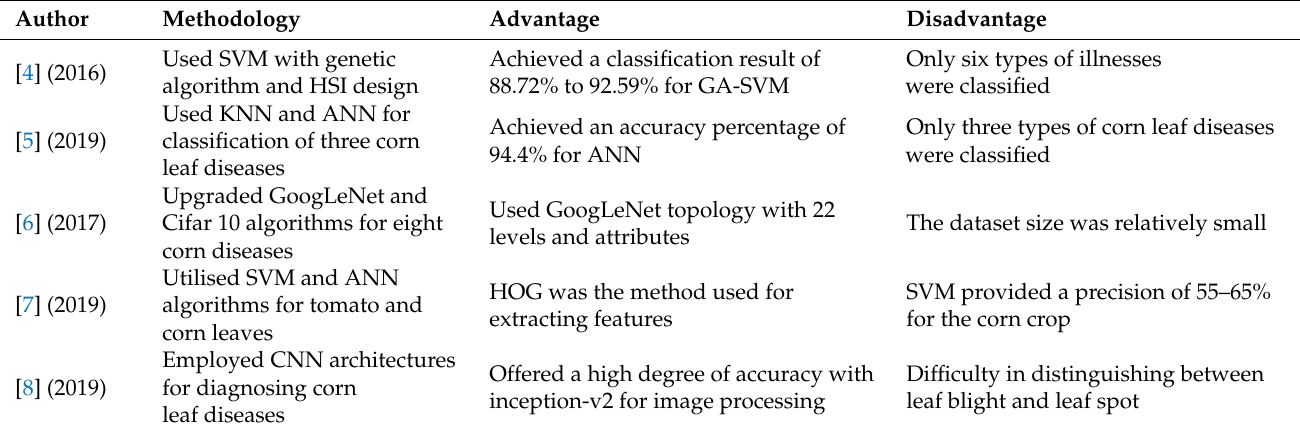
Table 1 summarises the state-of-the-art works in plant leaf disease identification. Table 1. Summary of state-of-the-art